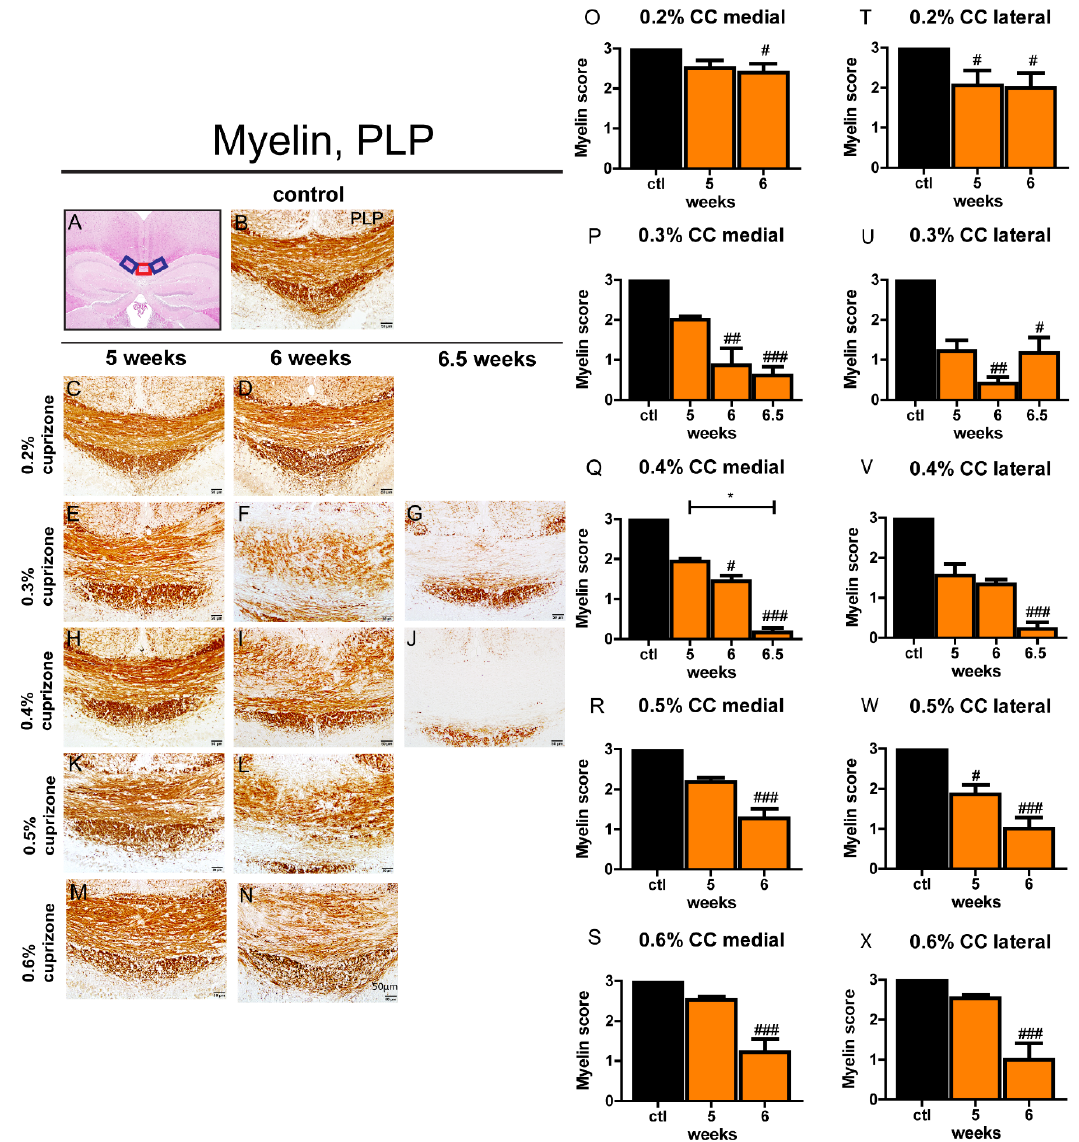
Figure 1. PLP loss during demyelination in the corpus callosum of aged mice. Hematoxylin and eosin (H & E)-stained control mouse brain ( A ) shows the areas of the corpus callosum that were analyzed (red box: medial part; blue boxes: lateral parts). Representative PLP-stained sections ( C – N ) show a decrease of PLP-positive myelin fibers during the course of demyelination in the central corpus callosum of aged mice after cuprizone treatment with different concentrations (0.2–0.6% cuprizone) for different feeding periods (5, 6, or 6.5 weeks). An exemplary picture ( B ) shows PLP staining in the midline of the corpus callosum of an age-matched control animal. A myelination score of 3 represents complete myelination, whereas a score of 0 represents complete demyelination. Graphs display the myelin score per time point and group in the midline ( O – S ) and in the lateral part of the corpus callosum ( T – X ) in aged animals. Bars represent mean + SEM. Significant e ff ects between di ff erent investigated time points are indicated by asterisks and e ff ects in comparison to control are indicated by hashmarks (* / # p < 0.05; ** / ## p < 0.01; *** / ### p < 0.001). Ctl. = control; 5, 6, or 6.5 weeks = treatment period with cuprizone for respective duration. N = 5–6 animals per